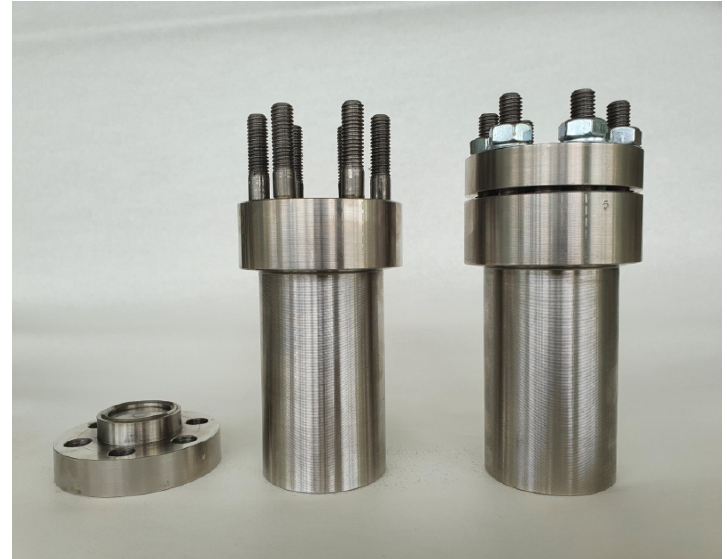
Figure 1. Autoclaves used in the experiment.